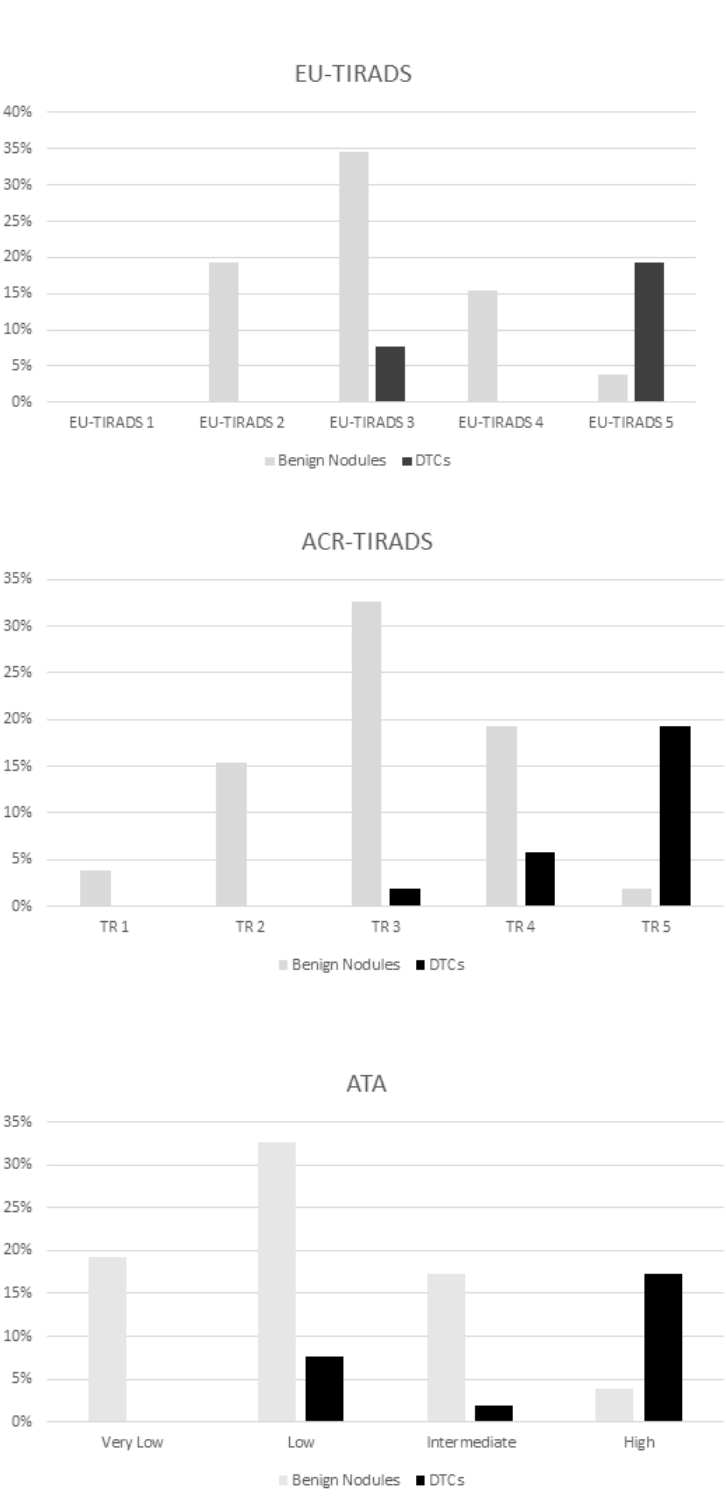
Figure 2. Distribution of benign and malignant thyroid nodules among the categories of the three US-RSSs. Table 3. Frequency of malignancy according to the various US-RSSs .